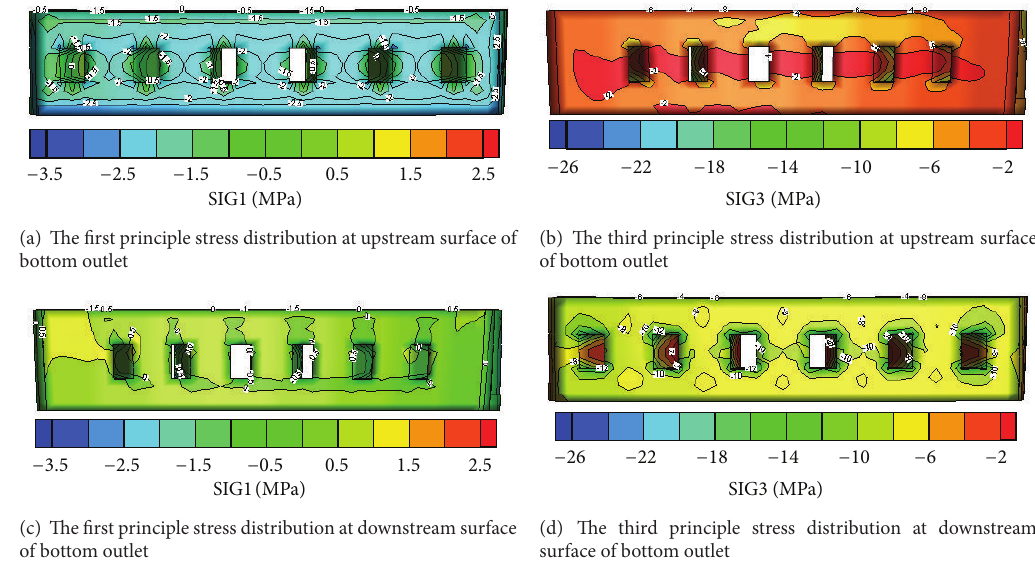
Figure 9: The first/third principle stress distribution of bottom outlets under analysis case